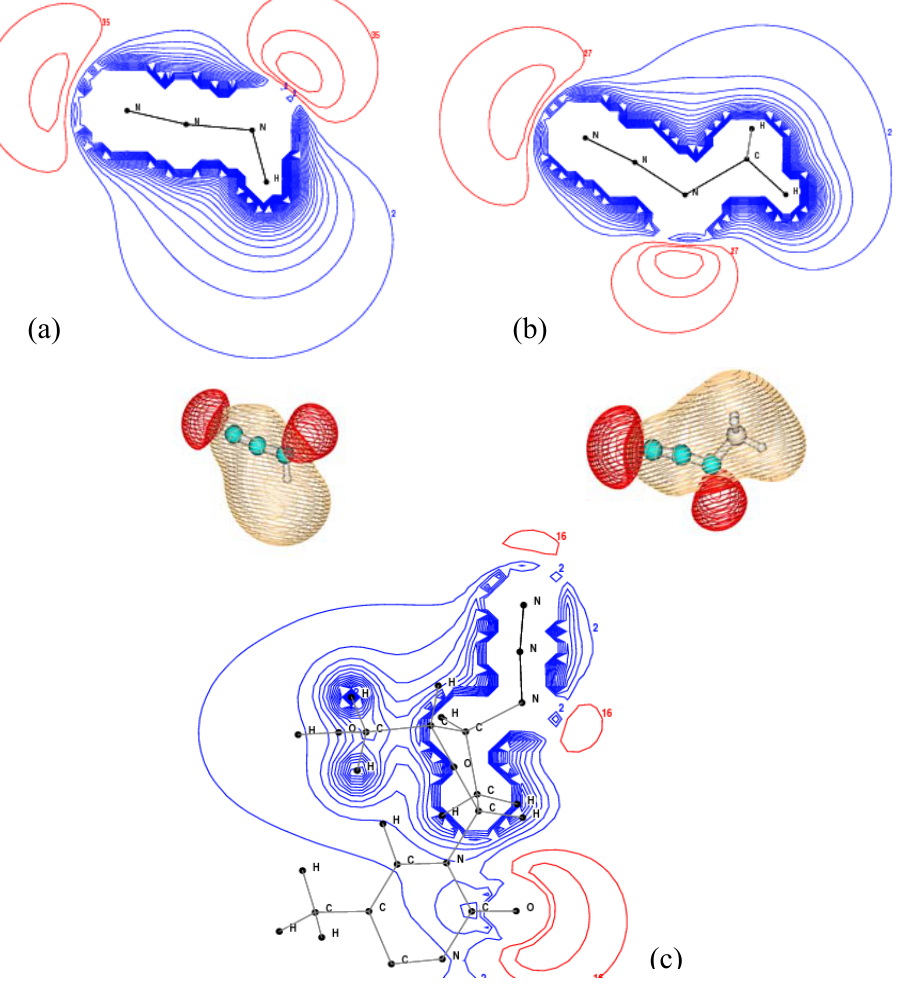
, (b) CH N , and (c) 3 3 3